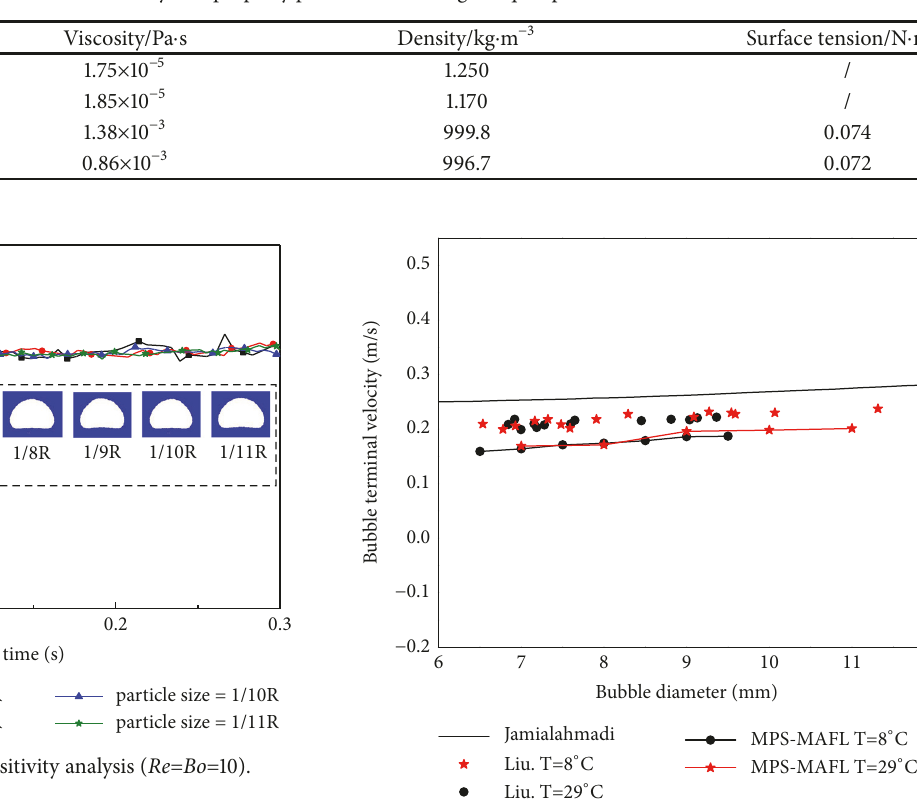
Figure 3: Terminal rising velocity of the bubble under different initial bubble diameter